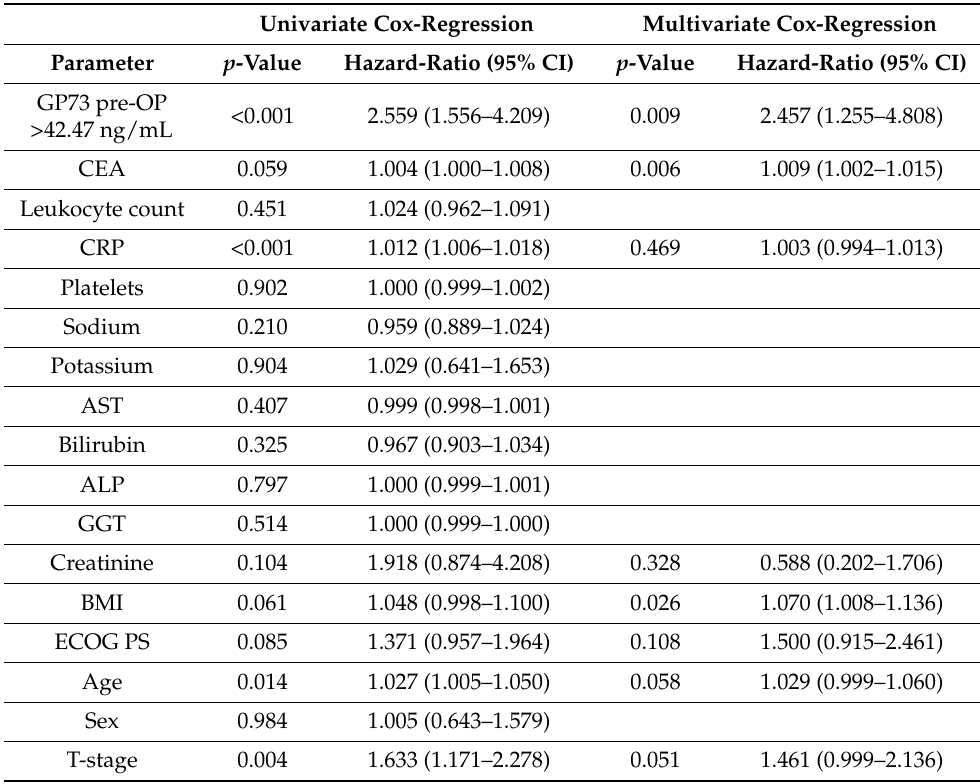
Table 2. Uni- and multivariate Cox-regression analyses regarding overall